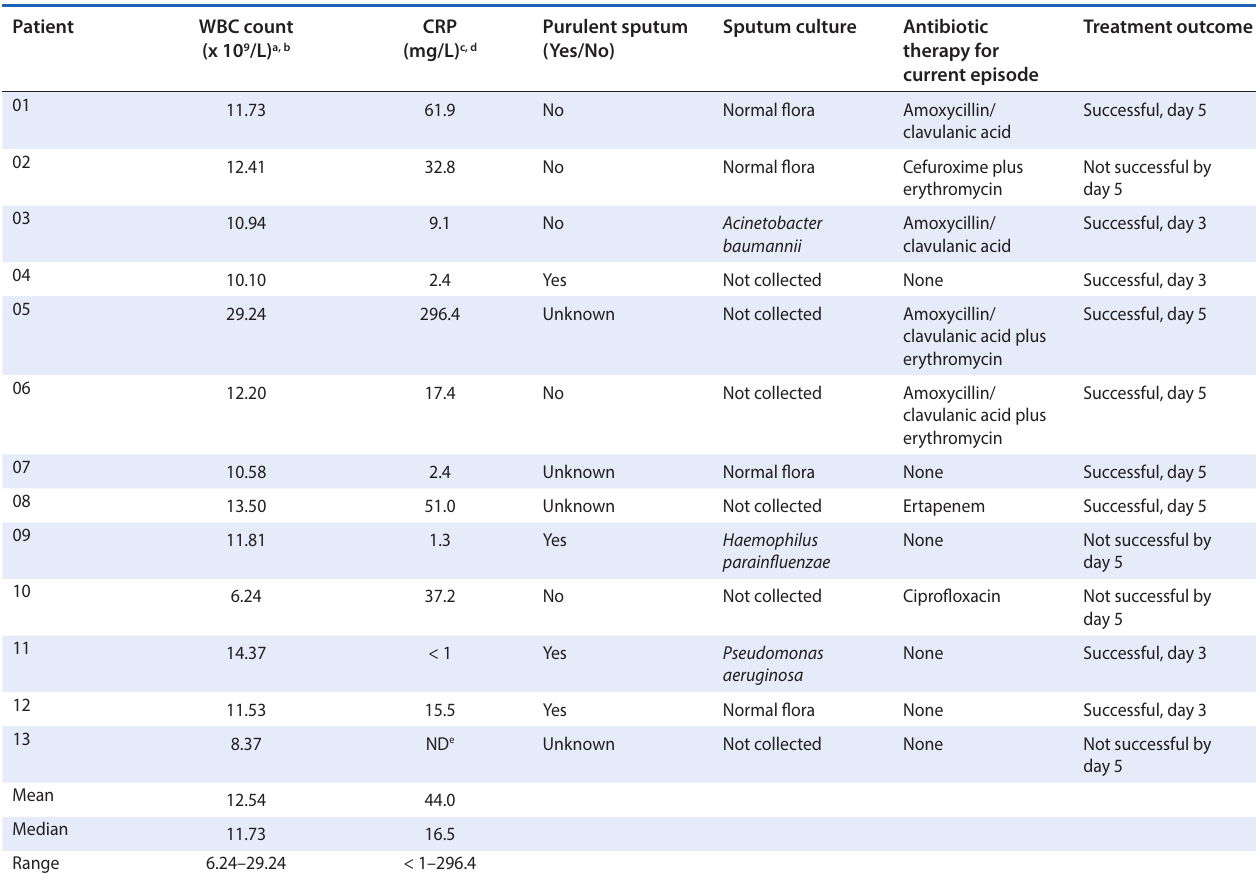
Table 2: Infection markers, sputum appearance and culture, and antibiotic therapy of patients hospitalised for acute exacerbation of COPD